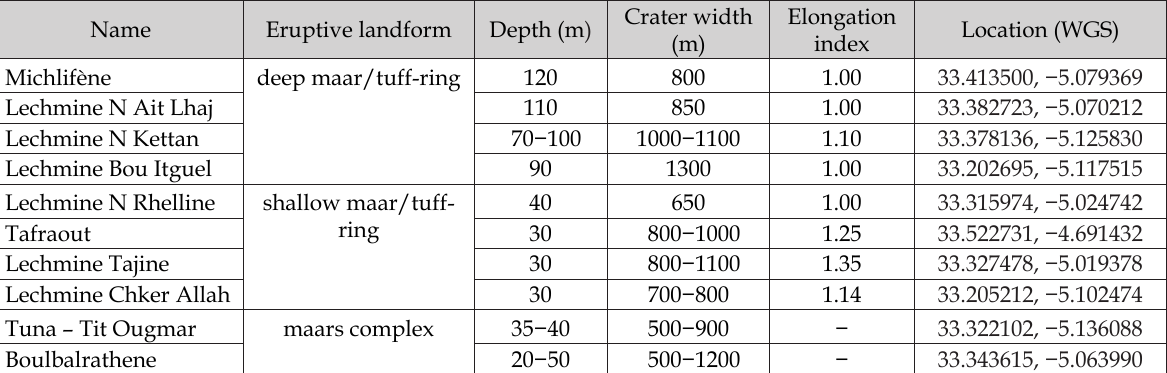
Table 2. Classification table of maars associated to tuff-rings according to their eruptive landform, depth, cra- ter’s width, elongation index, and the geographic location.